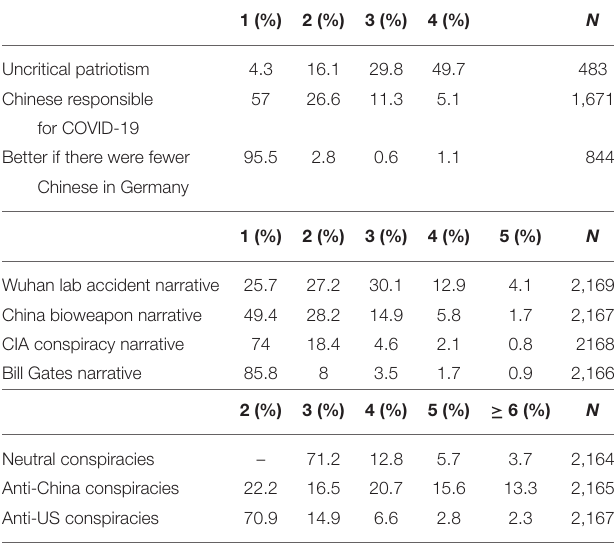
TABLE A1 | Descriptive results for the German sample.